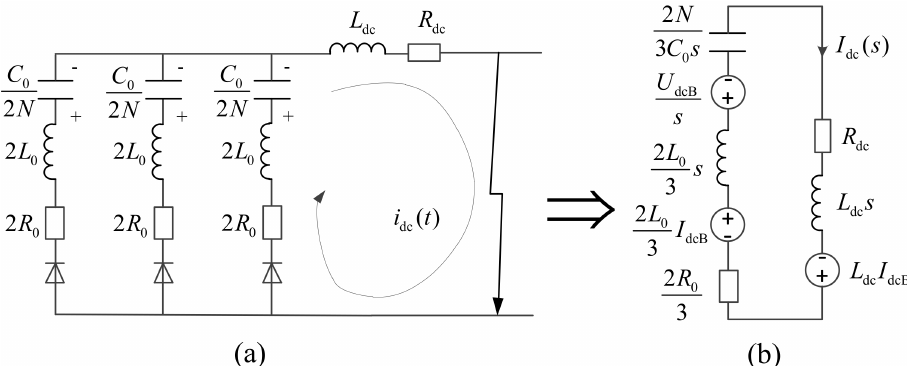
Figure 7. Circuit after the FMMC is blocked. ( a ) Equivalent circuit; ( b ) Operation circuit.